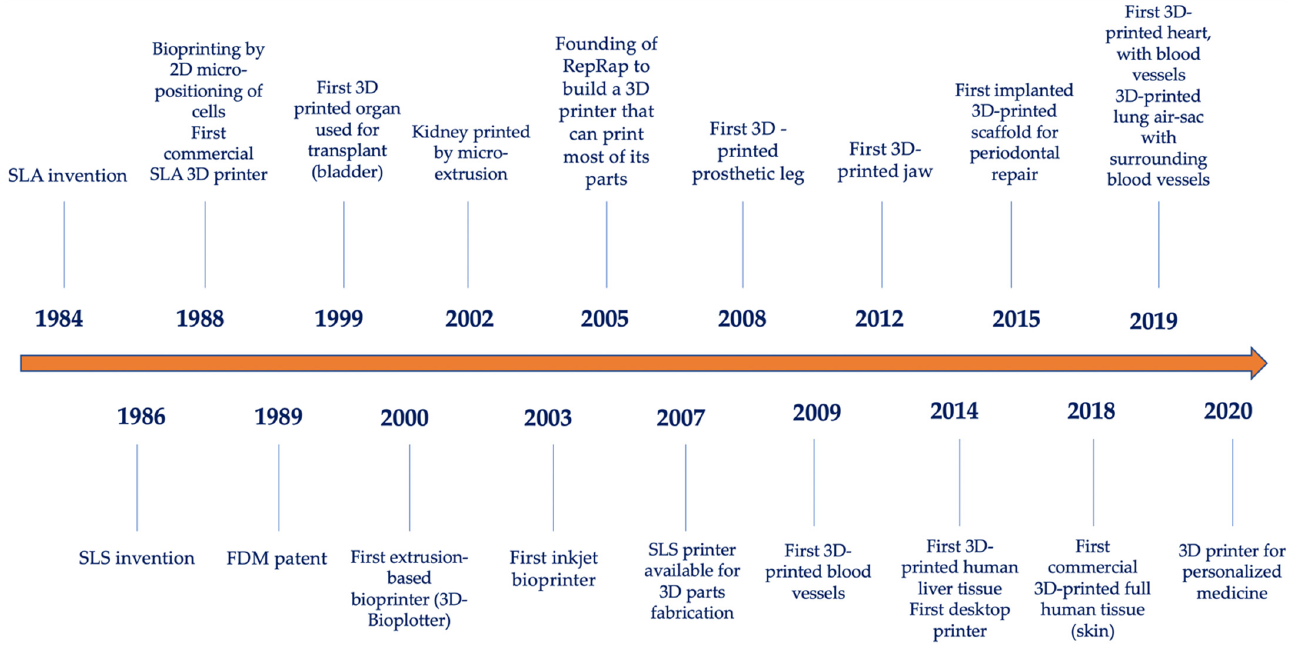
Figure 1. The evolution of 3D printing technologies.